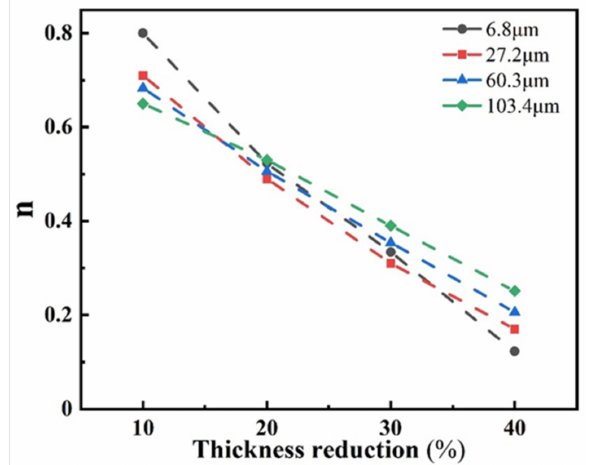
Figure 8. Relationship between work-hardening index n and the reduction of samples with different grain sizes.